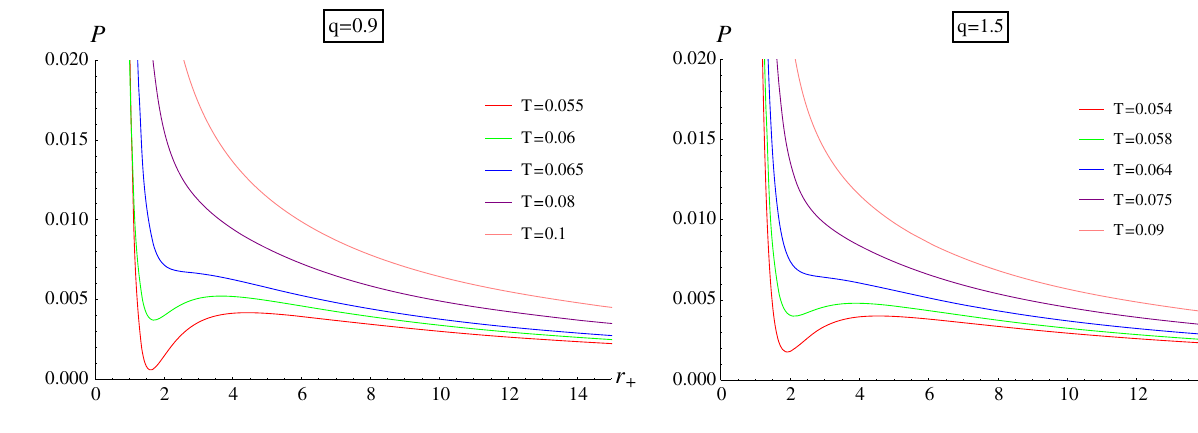
In T < T c , the isotherms consist of three different branches of the black holes. The branch with very large | ∂ P /∂ r + | or the high pressure is related to the small black holes. The branch with small | ∂ P /∂ r + | or the low pres- sure corresponds to the large black holes. The oscillating branch between the small and large black holes is the